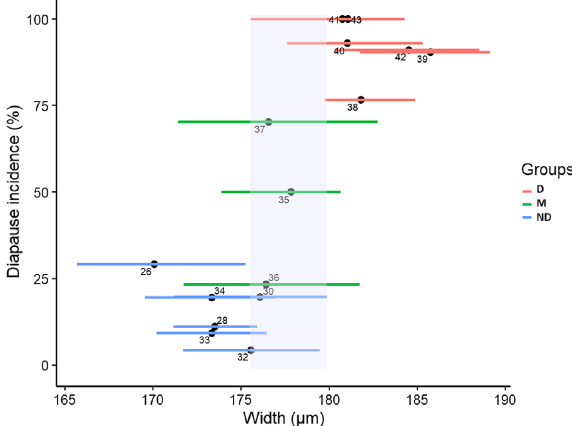
Figure 6. Association between the width of the eggs and diapause incidence. Data come from 2019 and the Reichstett fi eld area. Eggs are batched according to the calendar week of collection. For each week, average diapause incidence is used. Width of eggs is shown as dots for median values and lines as interquartile ranges. Three groups are de fi ned depending on their week of collection: group ND from weeks 26 to 34 (in blue), group M from 35 to 37 (in green) and group D from 38 to 43 (in red). An overlap in width between group ND and D is highlighted in pale